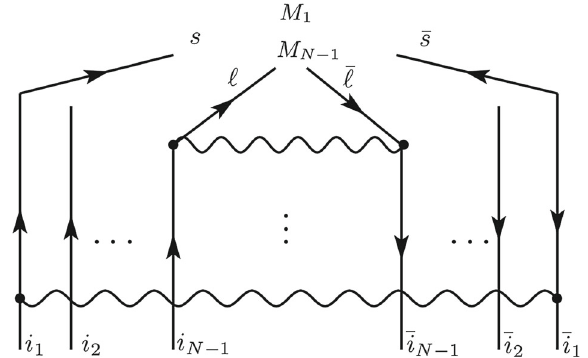
Fig. 5 Feynman diagrams for the tetraquark decays into N − 1 mesons